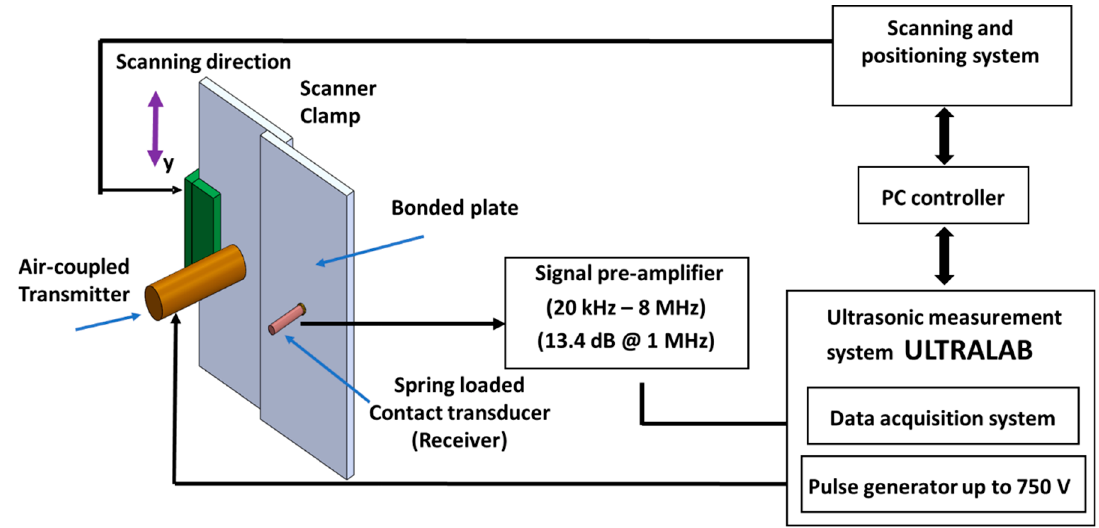
Figure 8. Guided wave inspection set-up with air-coupled to contact ultrasonic transducer.